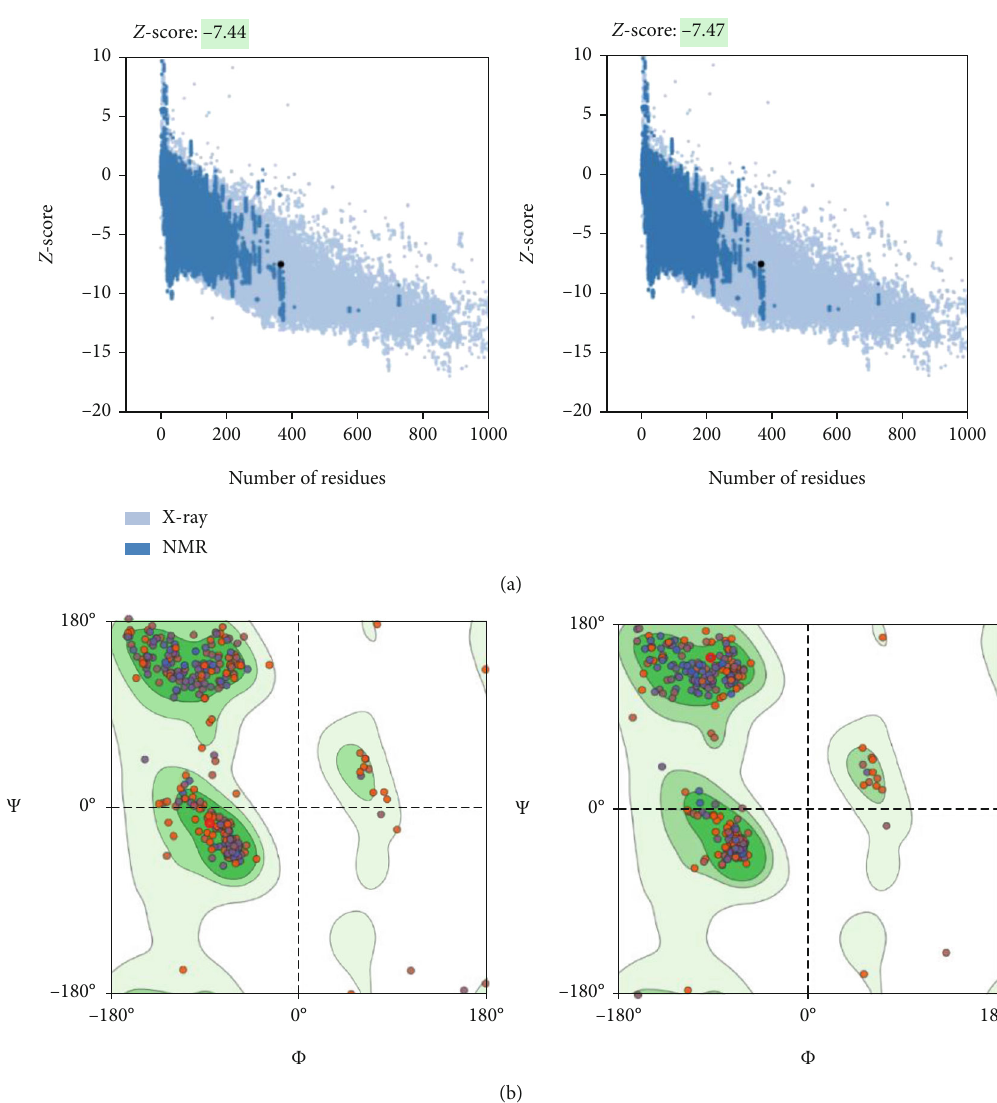
Figure 5: Validation of 3D model of CDPK7 protein. (a) The Z -score plot for 3D structure of predicted protein before and after re fi nement with ProSA-web server, respectively; (b) Ramachandran plot analysis of predicted